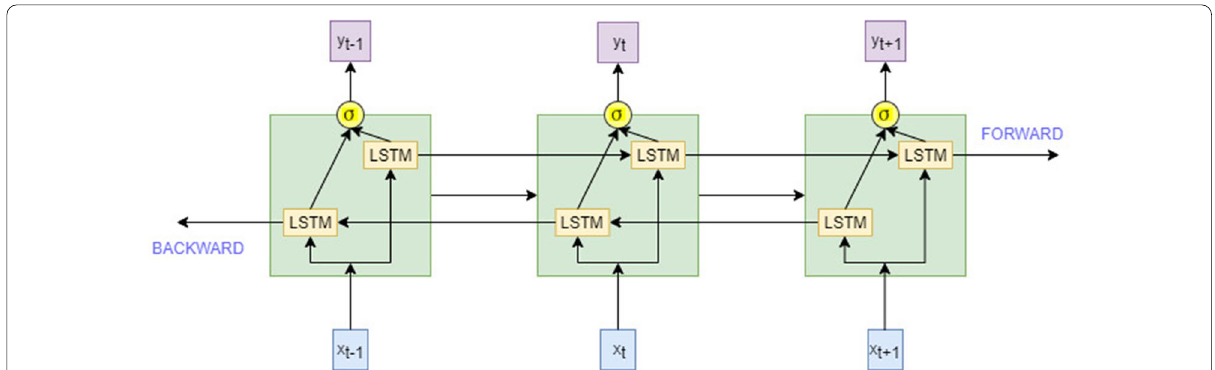
Figure 4 A Bi-directional LSTM